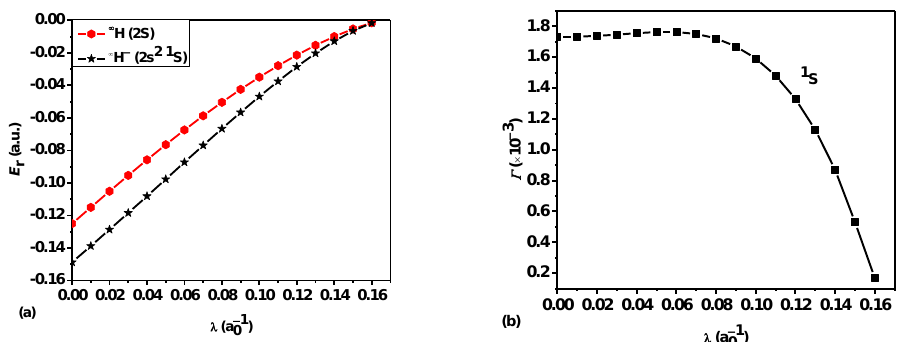
Figure 9. ( a ) Plot of the lowest 1 S e resonance energy 𝐸 𝑟 of ∞ H − as a function of 𝜆 . ( b ) Plot of the corresponding resonance width 𝛤 of ∞ H − as a function of 𝜆 .